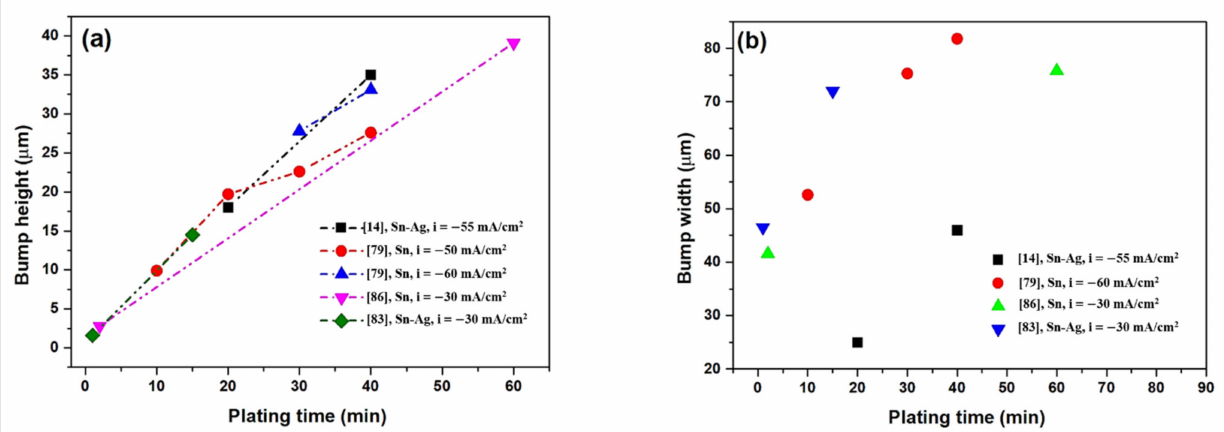
Figure 18. The increase of ( a ) bump height; ( b ) bump width with increasing plating time for Sn and Sn-Ag in the